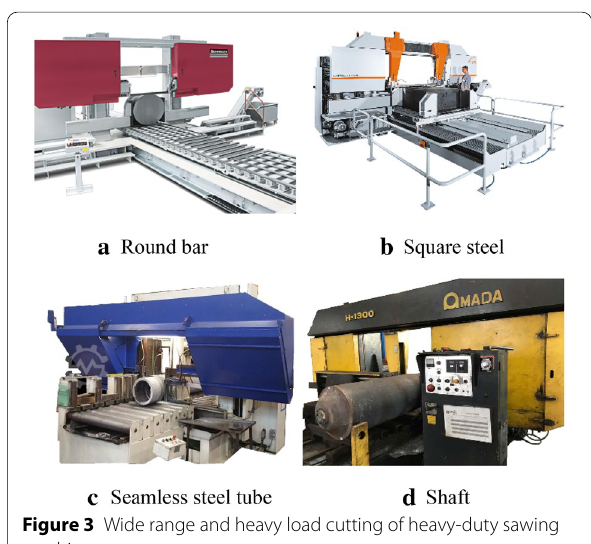
Figure 3 Wide range and heavy load cutting of heavy-duty sawing